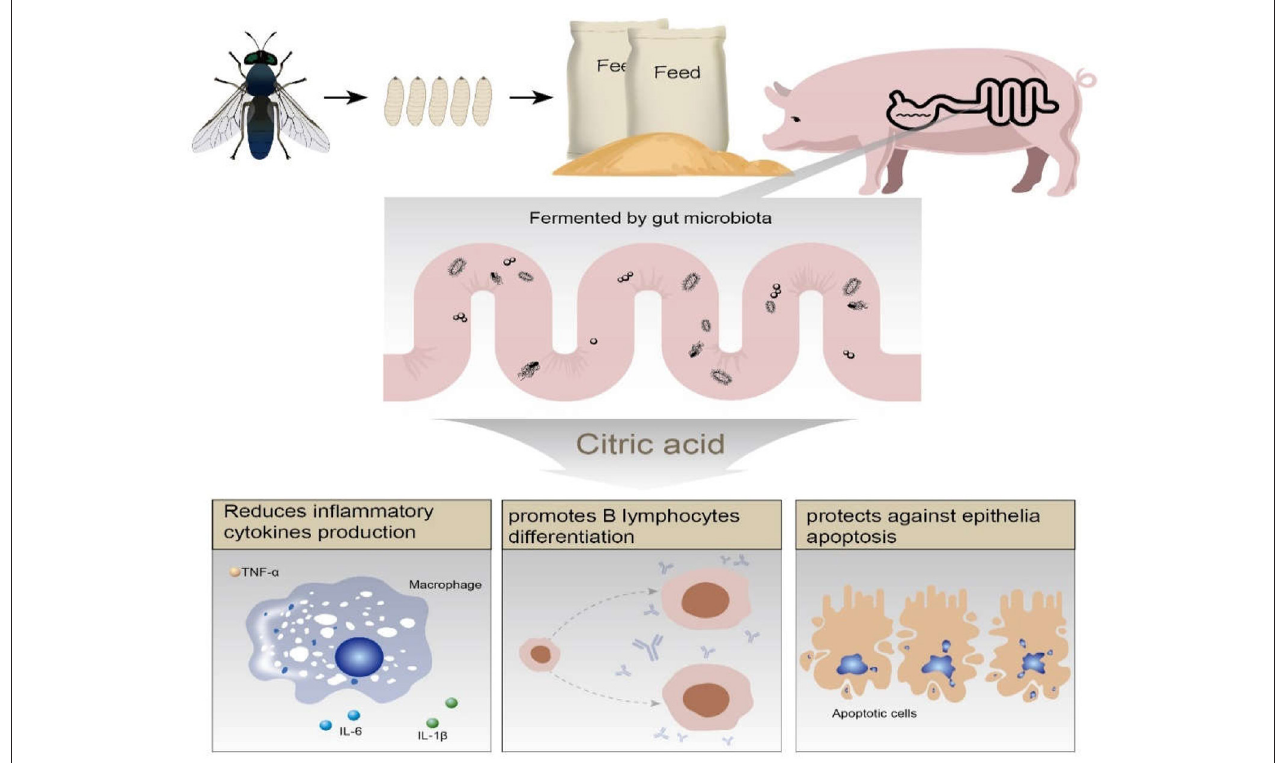
FIGURE 8 | Schematic representation of the proposed